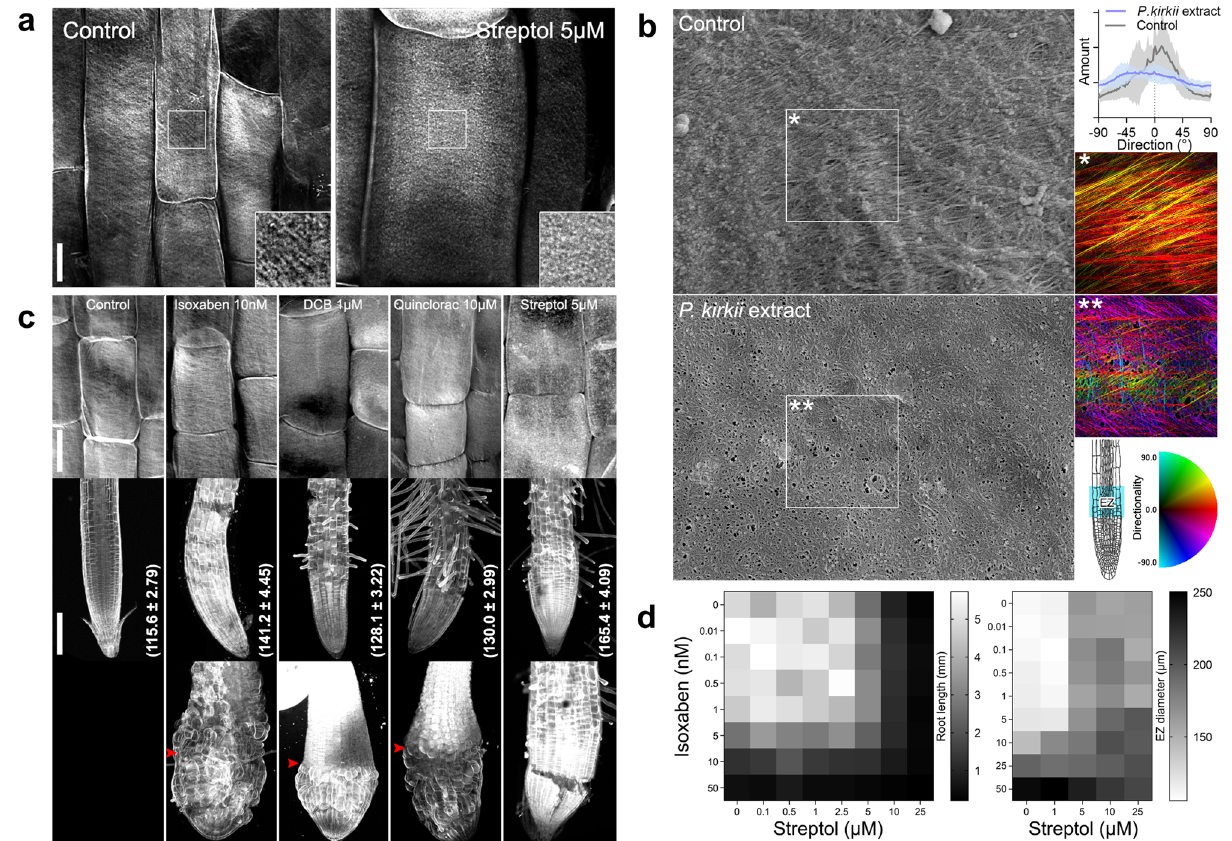
Figure 4. Streptol disorganizes plant cell walls in elongating root cells without inhibiting cellulose production. ( a ) Direct Red 23 cellulose staining of rapidly elongating epidermal EZ cells in presence or absence of 5 µM streptol. Insets show twofold magnification of the signal. Maximum projections of CLSM optical sections. Note that the same scale and acquisition settings were used for both samples. Bar = 10 µm. ( b ) Scanning electron micrographs of the EZ external epidermal surface of control and P. kirkii extract-treated roots; 50kX magnification. Insets marked with asterisks depict the local Fourier components orientation map, color- coded as in the HSB wheel according to angle, power spectrum and image grey values, respectively. Top right, directionality histograms distribution of cellulose microfibrils. Data represent the mean values of three biological replicates (five cell surface samplings per seedling), standard deviations are indicated. ( c ) Direct Red 23 cellulose staining of root apices in presence or absence of the given inhibitors. Top, first elongating EZ cells. Bar = 10 µm. Middle, corresponding root apex phenotypes. Numbers in brackets indicate mean EZ diameter and standard errors in micrometres (15 seedlings each). The means of each treatment were found significantly different from water control (one-way ANOVA with Dunnett’s post-hoc test, p -value < 0.05). Bar = 100 µm. Bottom, root apex phenotypes at root growth-restrictive concentrations. Arrowheads indicate the root-shoot junction. Maximum projections of CLSM optical sections. The same acquisition settings were used for all samples. Bar = 100 µm. All specimens were oriented to the longitudinal axis. ( d ) Streptol vs isoxaben checkerboard root growth and EZ diameter assay. Data represent the mean values of three independent